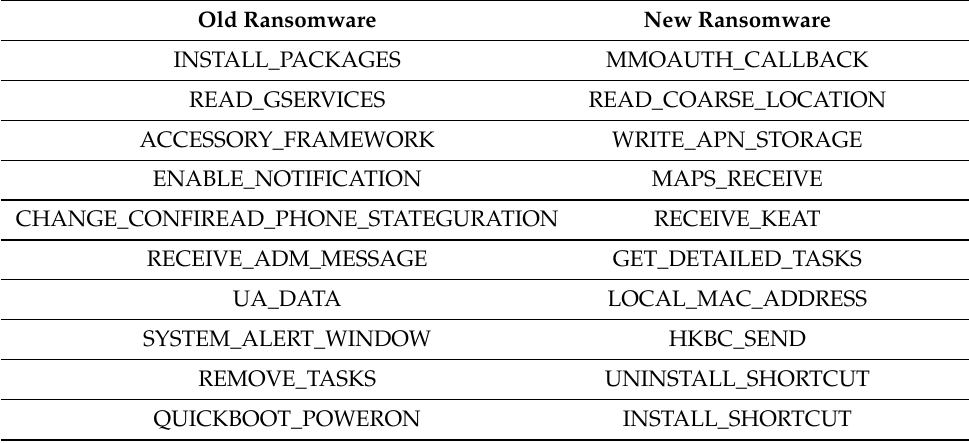
Table 6. Top-10 frequent permission features for old and new ransomware APKs.